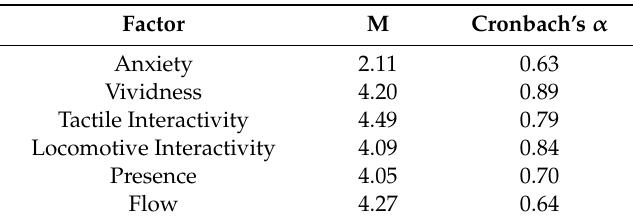
Table 4. Reliability of the